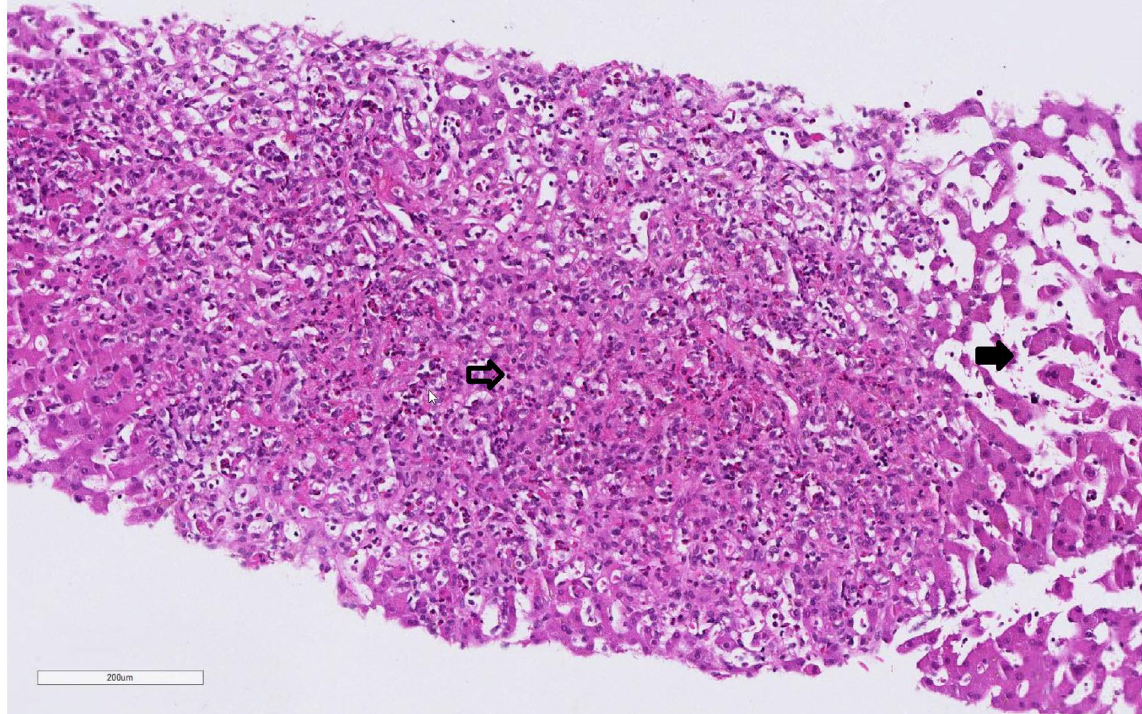
Figure 1. Case 1 liver biopsy: extensive centrilobular (zone 3 to 2) necrosis with fiber collapse and prominent eosinophilia (empty arrow). Presence of sinusoid dilatation (full arrow, hematoxylin-eosin, 20x)